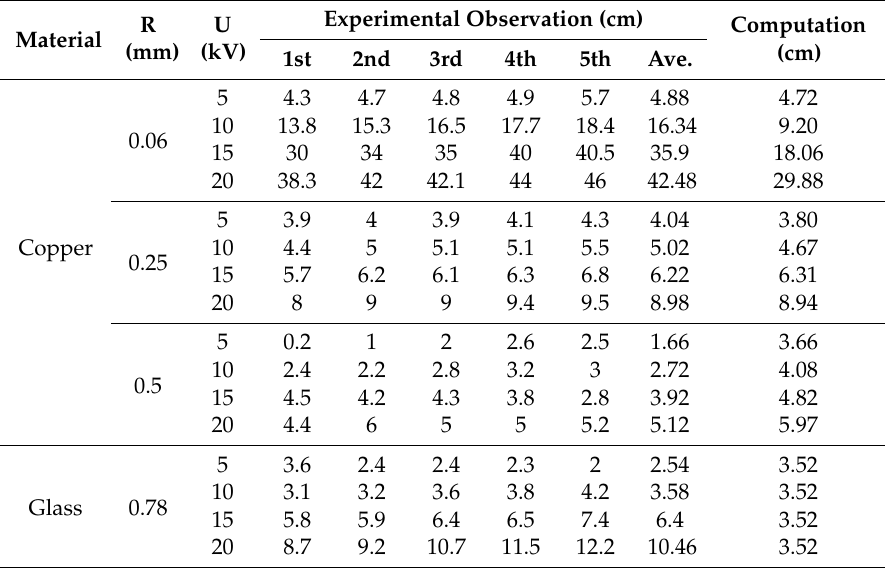
Figure 9. Trajectory simulations as applied voltage. (Radius of copper wire (r p ): 0.00025 m, length of copper wire (l p ): 0.01 m, initial speed (v 0 ): 0.13 m · s − 1 , distance between two electrodes (L): 0.6 m). Table 3. Particle trajectory by observation vs. simulation.